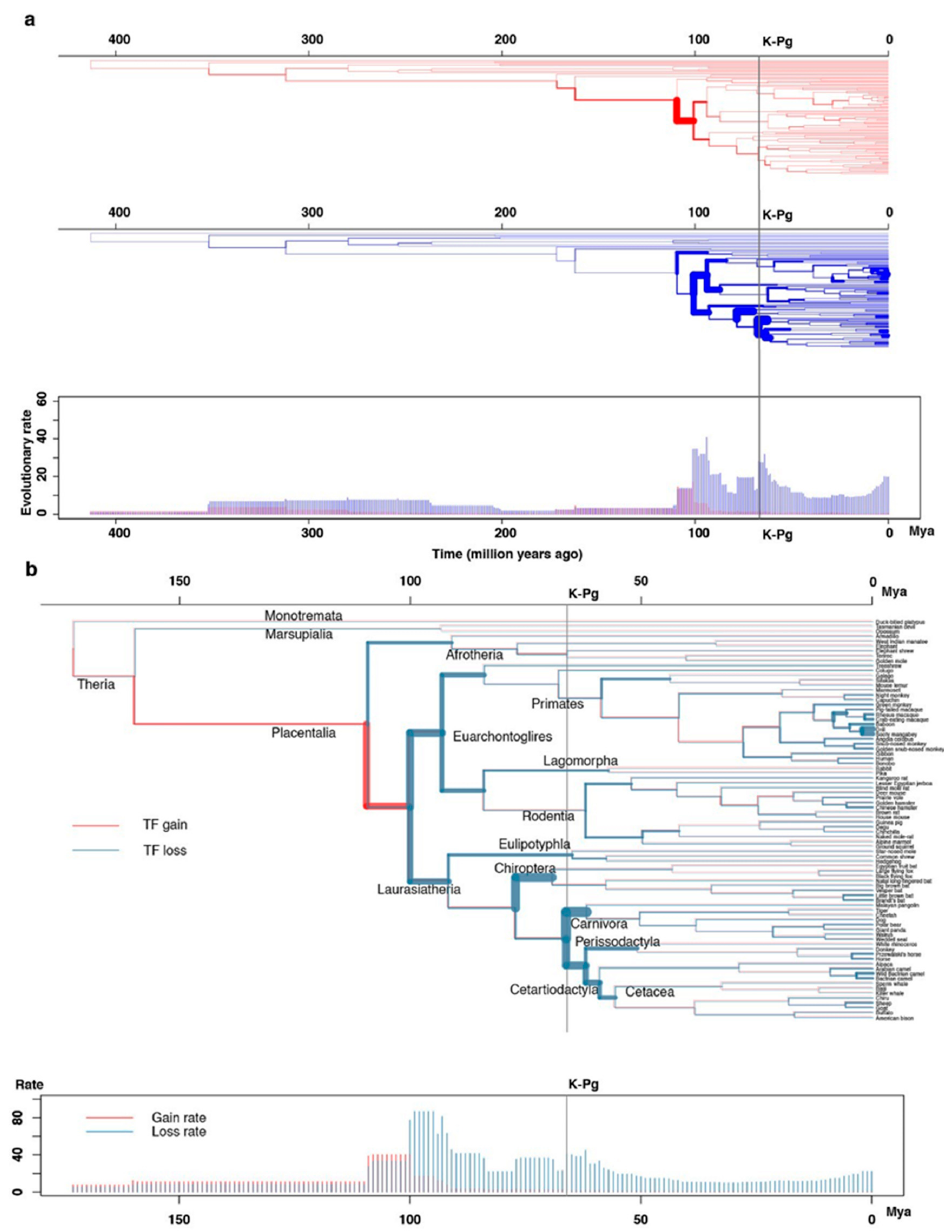
Figure 3. Atlas of ancient transcription factor (TF) gain and loss. ( a ) TF events in Atlantogenata inferred using an effective population size of 10 6 with outgroup species included. TF losses and gains are represented by blue and red bars, respectively. The width of each branch is proportional to the rate of TF gain (or loss). Divergence times of outgroups (Aves, reptiles, amphibians, etc., see Figure S1) originated from Timetree [22]. ( b ) Atlas of ancient TF gain and loss of 982 orthologous groups of TFs during mammalian history. The width of each branch is proportional to the rate of TF gain (or loss). Time scale is million years ago (Mya).